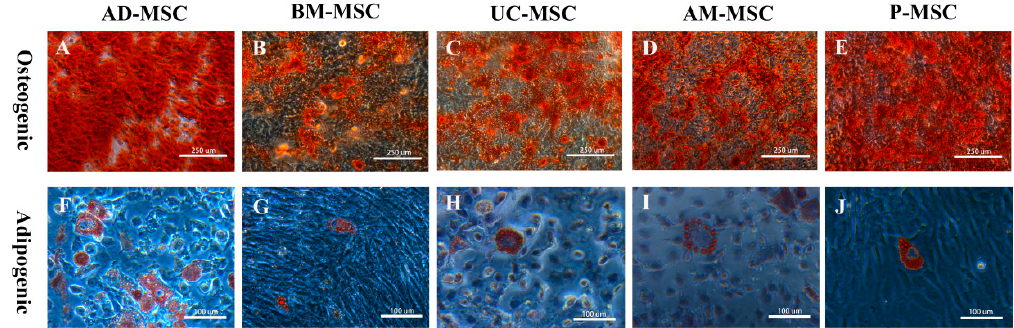
Figure 4. Results of osteogenic and adipogenic differentiation of the five types of MSCs. ( A – E ) Alizarin Red staining, 100×; ( F – J ): Oil Red O staining, 200×.